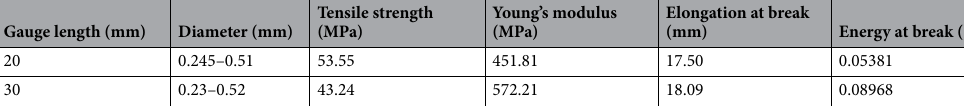
Tensile strength (MPa)